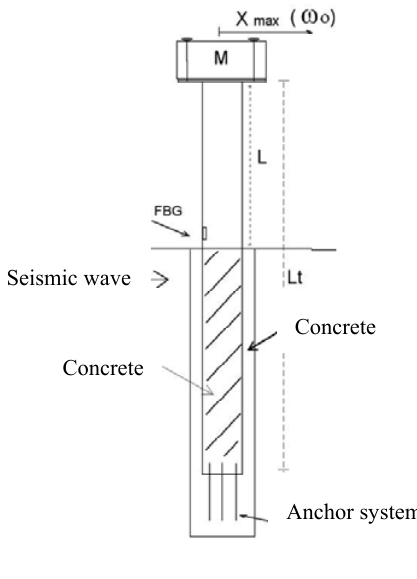
Figure 12 . Sketch of the flexural beam acceleration